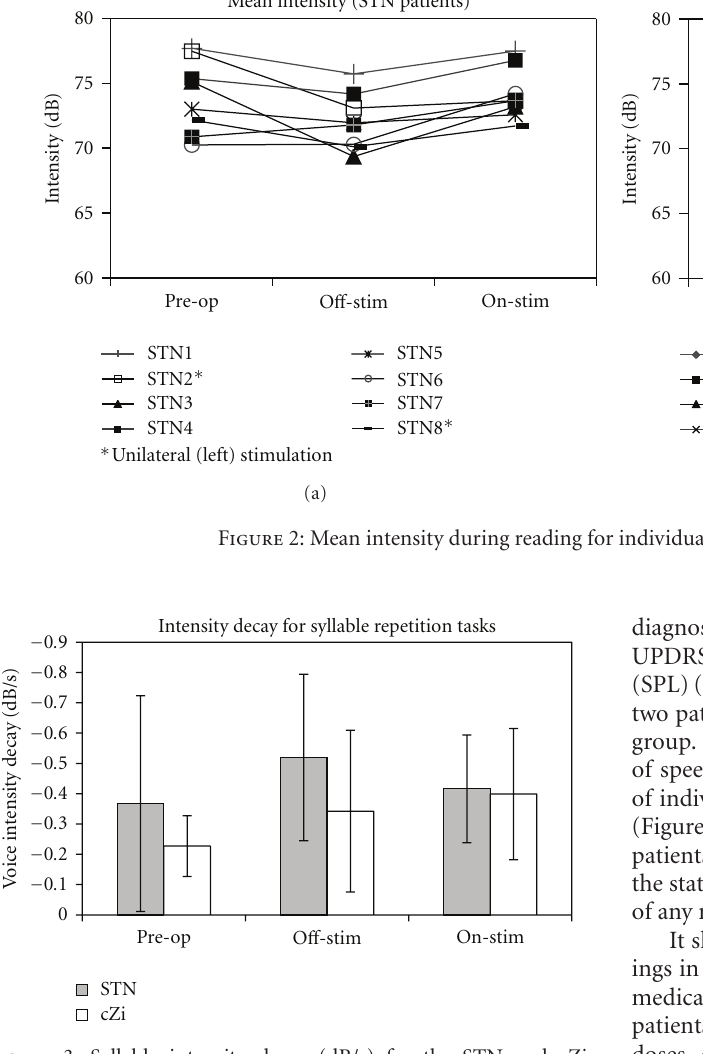
Figure 3: Syllable intensity decay (dB/s) for the STN and cZi groups respectively, showing means and standard deviations for preoperative and postoperative o ff - and on-stimulation testing